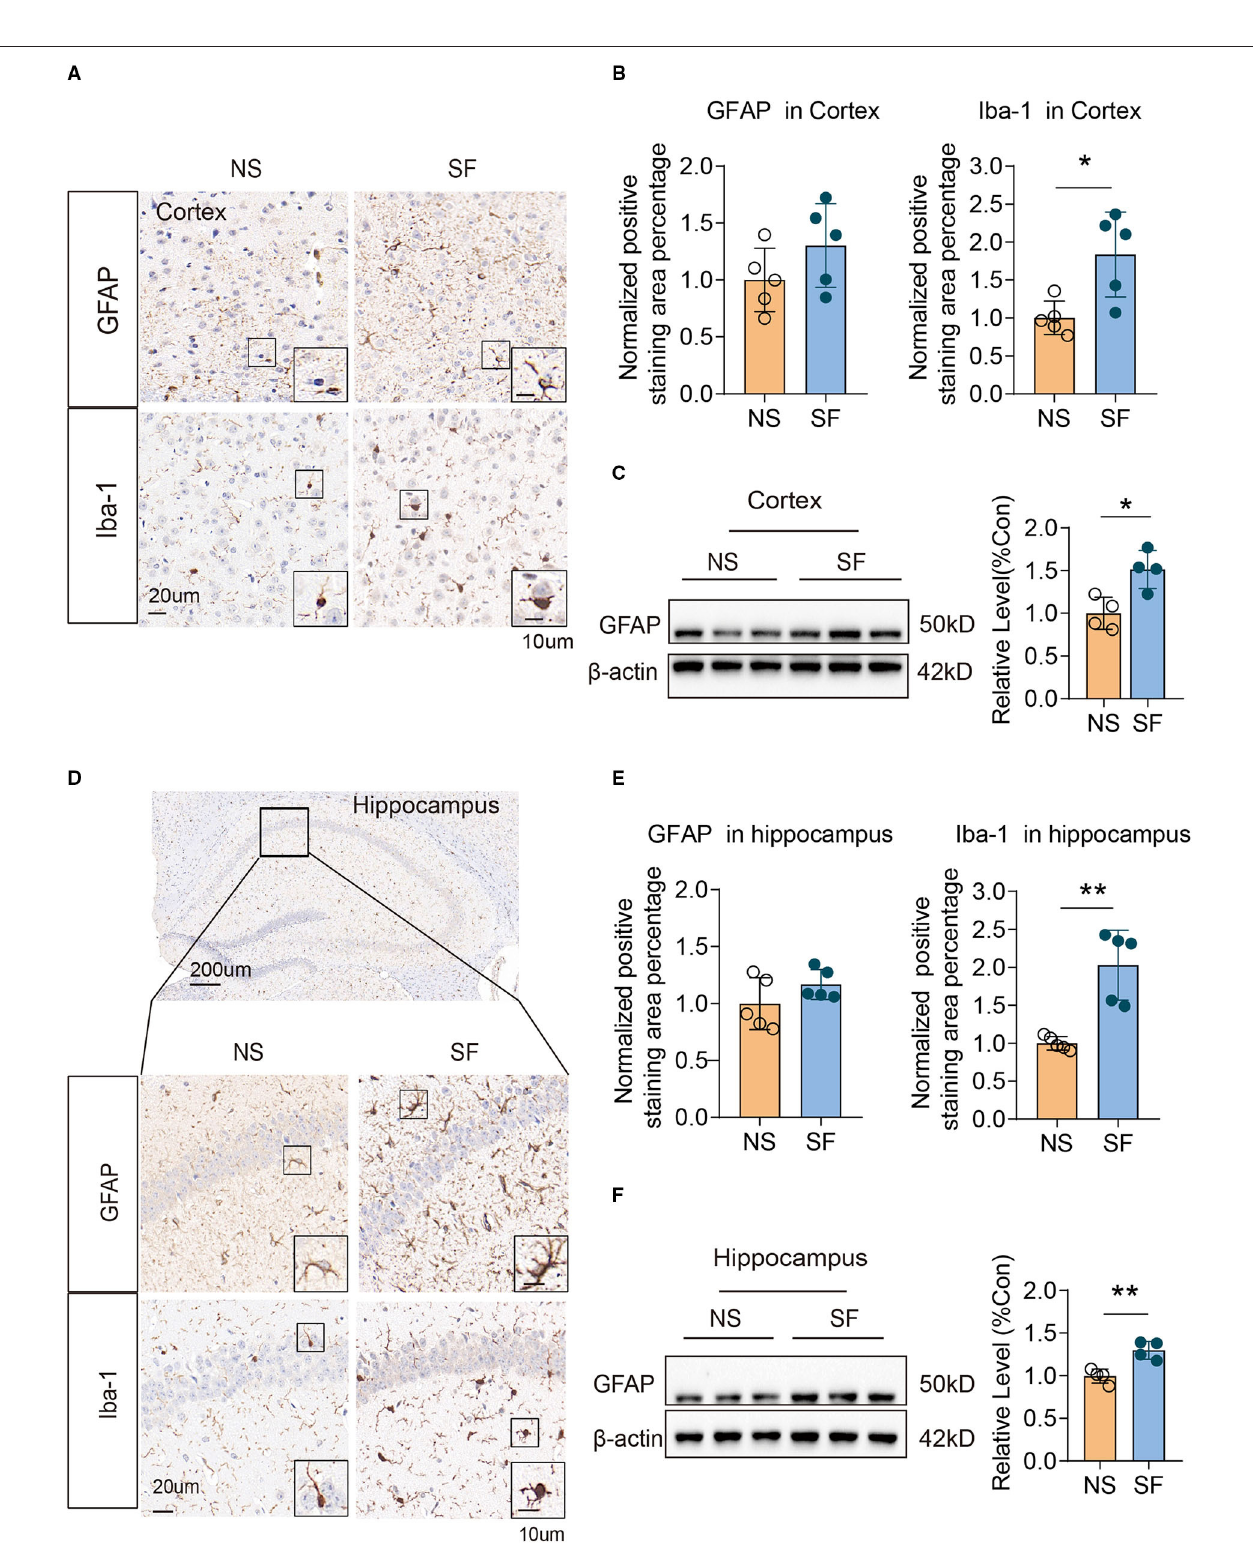
FIGURE 2 | Chronic SF induces gliosis in the mouse cortex and hippocampus. (A–C) Activation of astrocyte and microglia in SF cortex. (A) Representative immunohistochemistry images of GAFP and Iba1 staining in the cortex of NS and SF mice. Scale Bar = 20 µ m. Astrocytes labeled by GFAP, and microglia labeled by Iba1 were shown in the boxes. Scale Bar = 10 µ m. (B) Quantitative analysis of positive staining of GFAP and Iba1 in the cortex of NS and SF